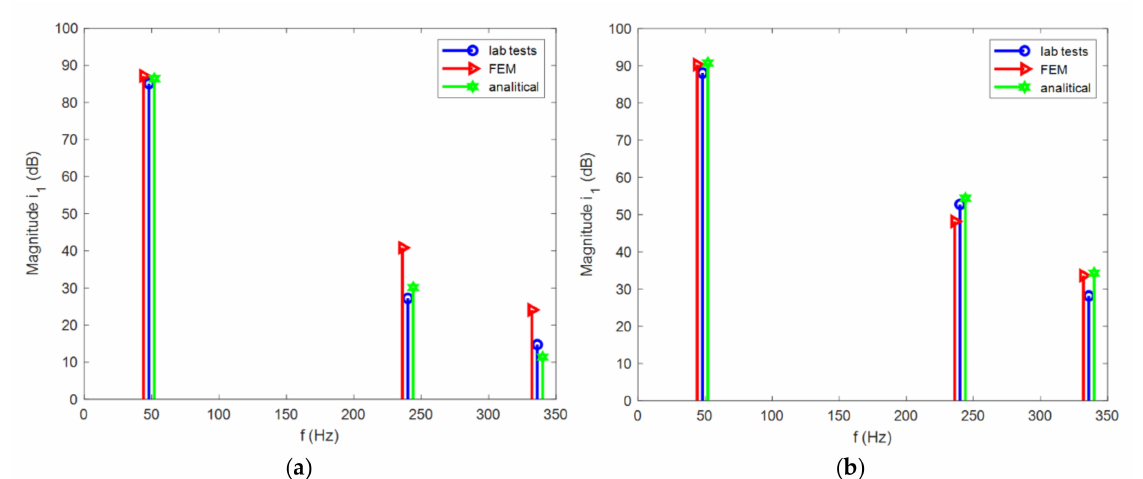
Figure 10. FFT spectrum of stator current ( a ) AFPMG—coreless stator ( b ) AFPMG—core stator.